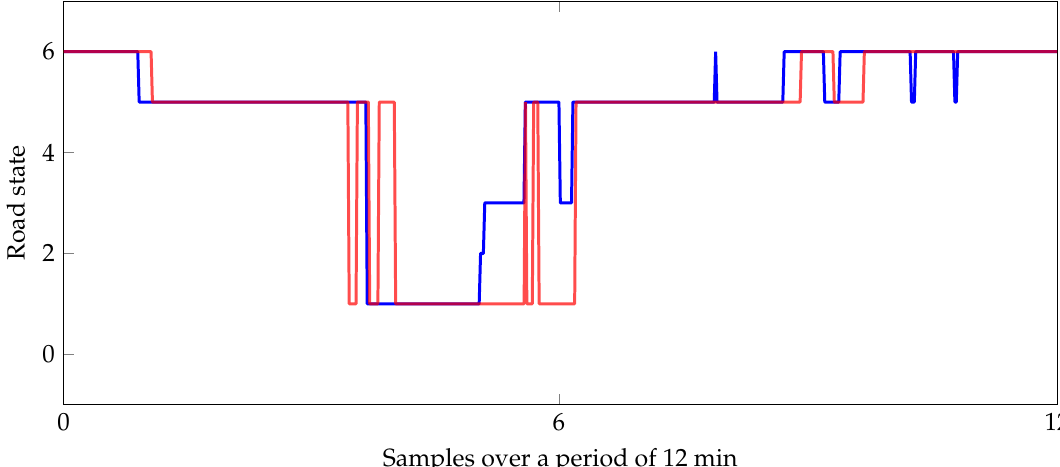
Figure 5. RCM411 road state plots from two runs along the same test route: blue, run 1; red, run 2.